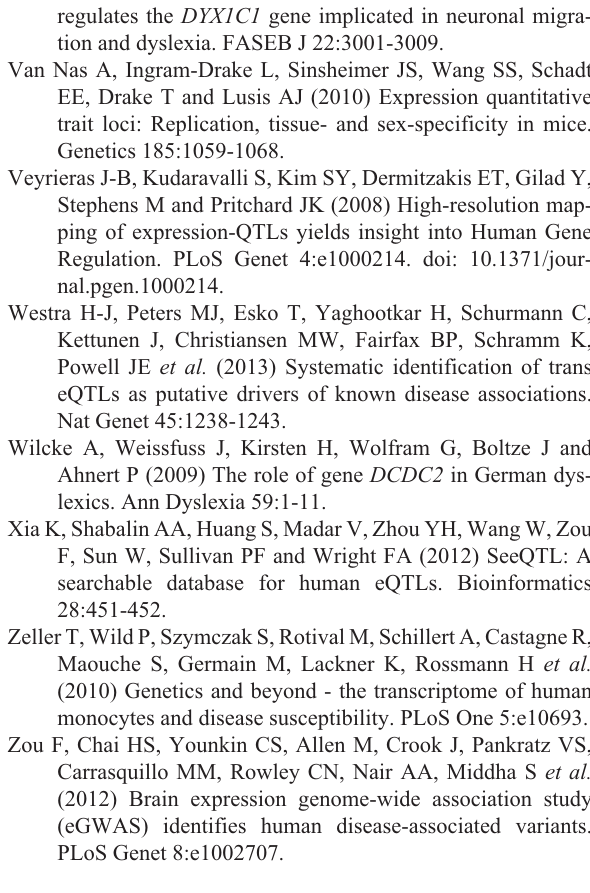
Table S1: Overview of considered SNPs. Table S2: Overview of SNPs related to dyslexia but not an- alyzed. Table S3: Primer sequences. Table S4: Number of sequences surviving quality control. Figure S1: Local association plot of rs600753. Figure S2: The effect of rs600753 stratified for